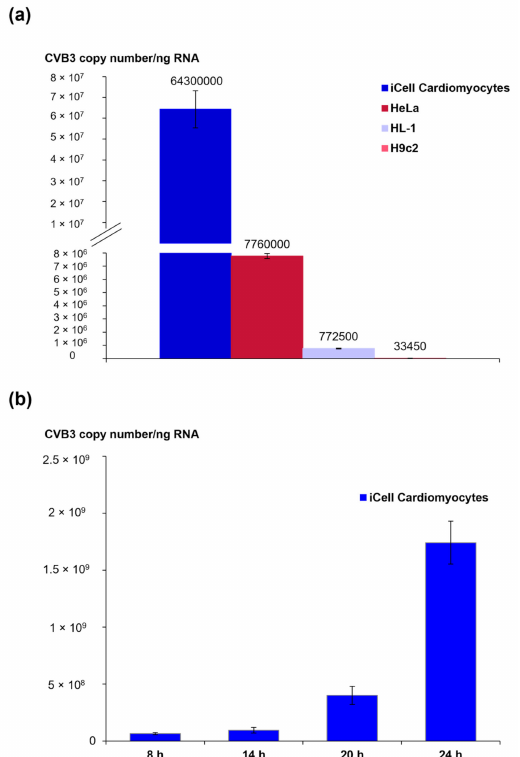
Figure 1. ( a ) Comparison of CVB3 load in different cell lines. CVB3 RNA copy numbers per ng RNA were obtained by qRT-PCR in CVB3-infected HeLa cells, HL-1 cells, H9c2 cells and iCell ® Cardiomyocytes, eight hours pi. ( b ) Quantification of CVB3 RNA copy number per ng RNA by qRT-PCR in CVB3-infected iCell ® Cardiomyocytes in the time course of